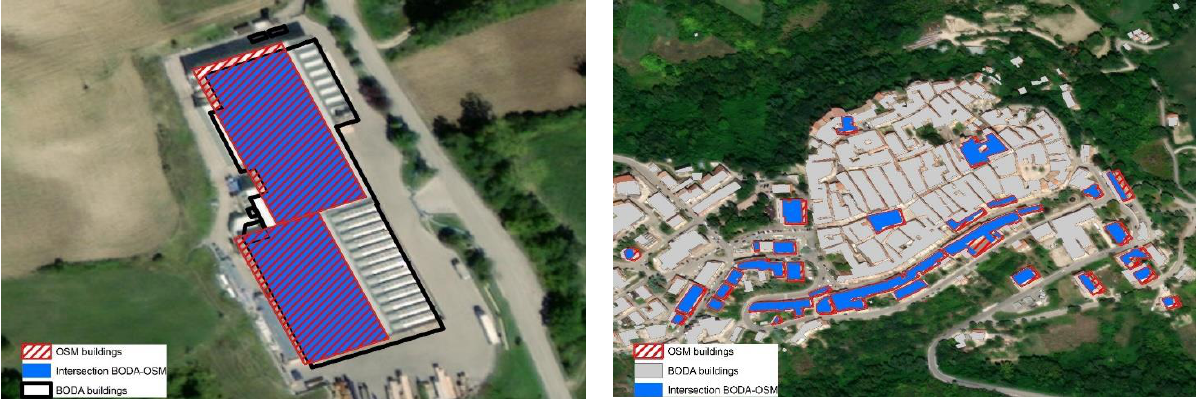
Figure 5. Examples of building intersection and the calculation of the related built-up surface area in Frosolone, Molise.